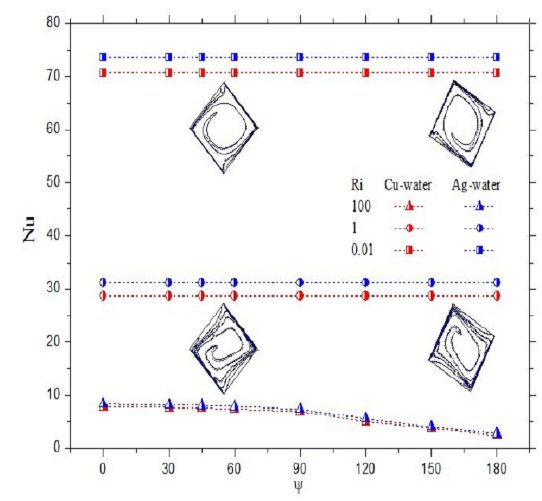
Figure 5: Nusselt number as a function of ψ for different values of Ri